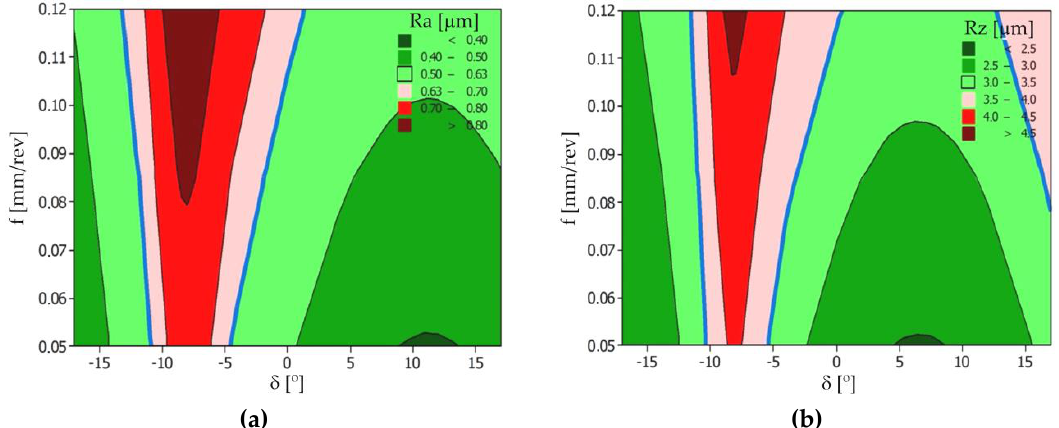
Figure 10. Graphs representing the relation between the tilted angle of the machined surface and the feed rate f for the surface roughness parameters: ( a ) Ra; and ( b ) Rz.